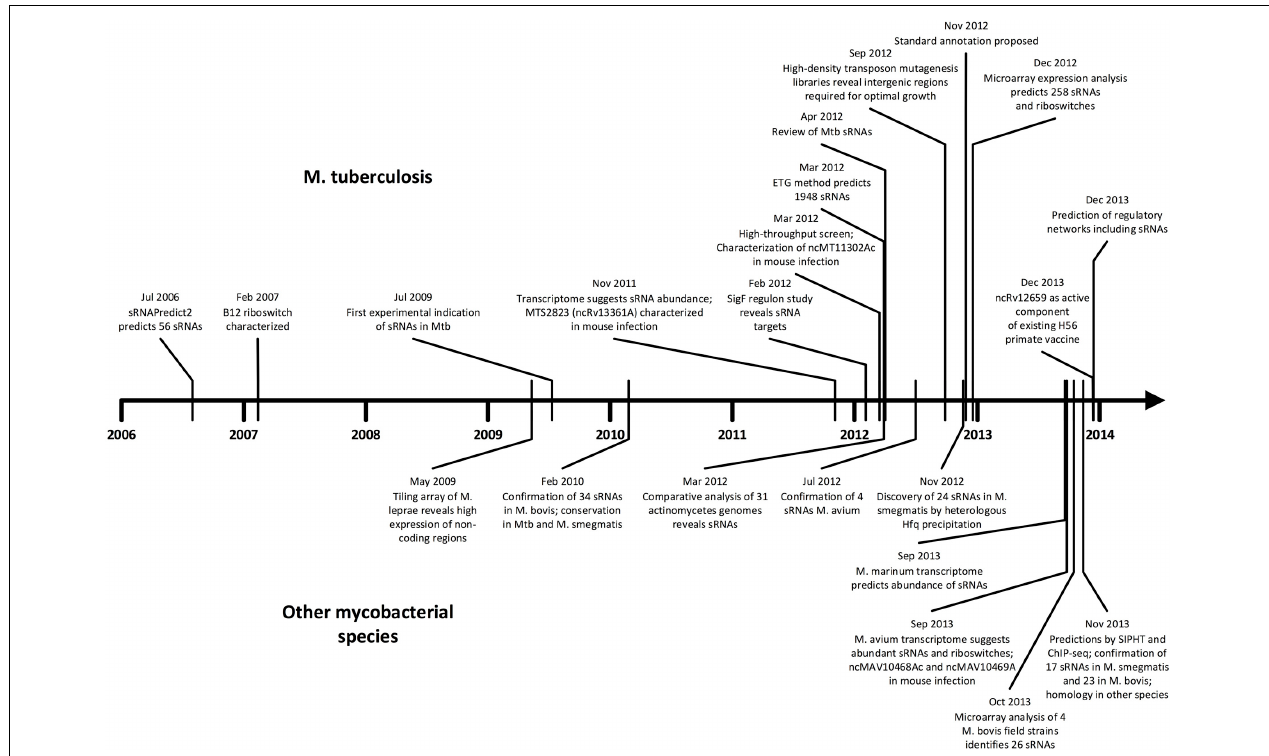
FIGURE 3 | TimelineofsRNAdevelopmentsinmycobacteria. Progressin M.tuberculosis (upper)andothermycobacterialspecies(lower)areshowninparallel in chronological order. The surge of studies in the last few years suggests momentum toward further discovery, mechanistic studies, and medical